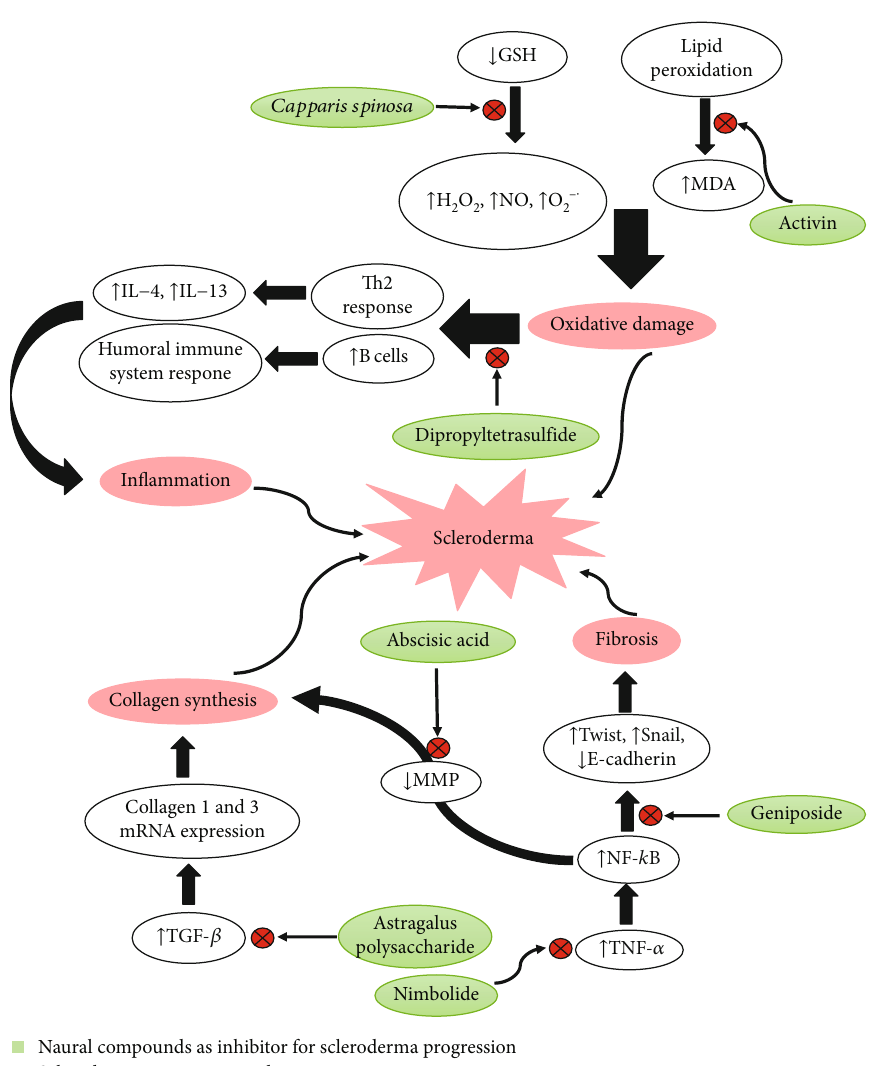
Figure 1: Pathogenesis of scleroderma; some natural compounds can inhibit its